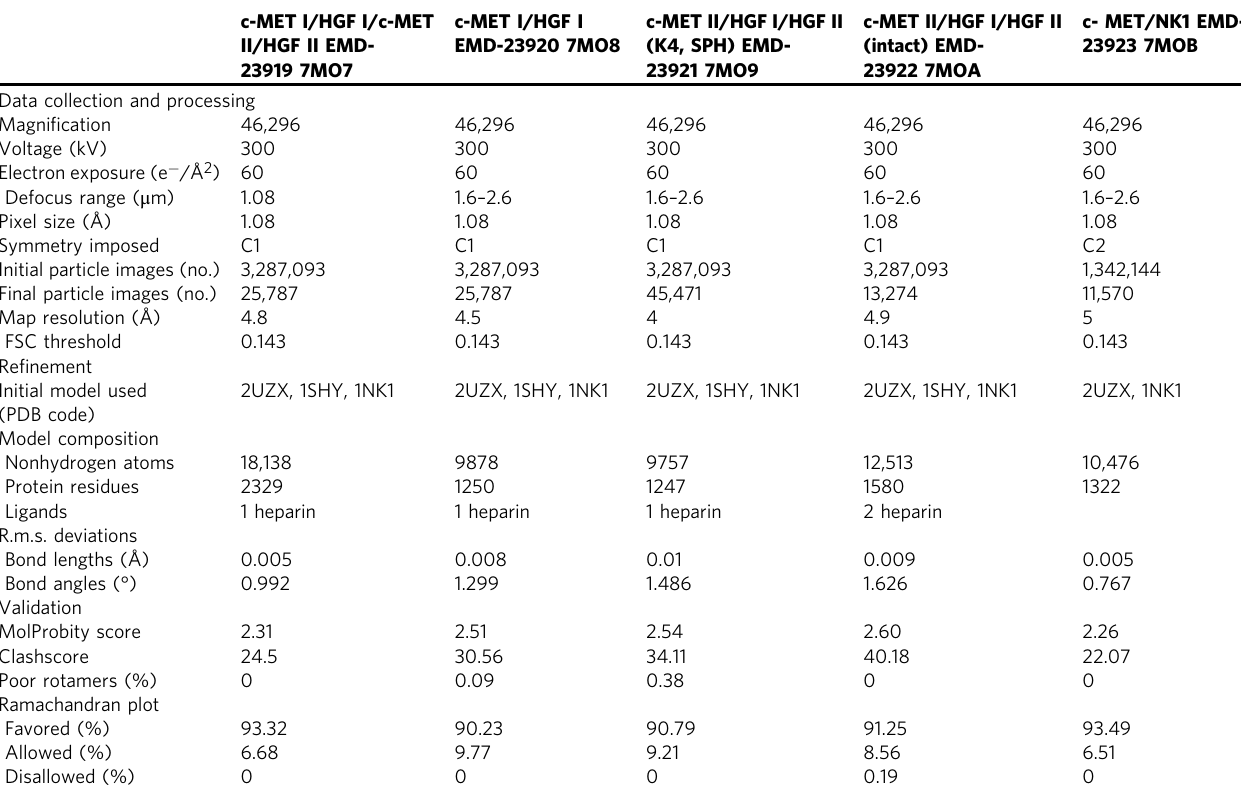
Table 1 Cryo-EM data collection, re fi nement, and validation